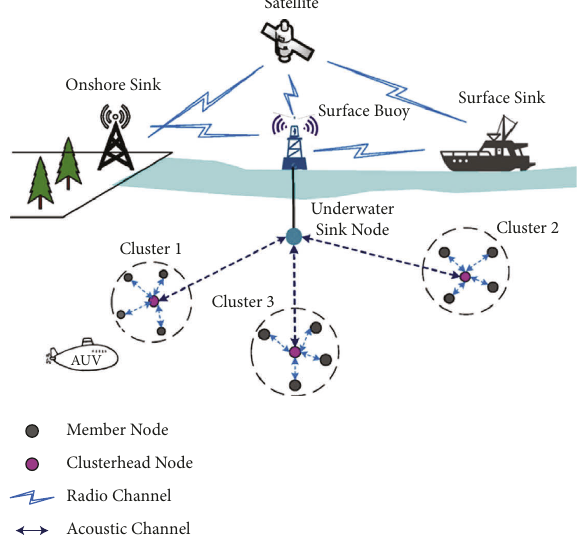
Figure 1: General structure of underwater wireless communication.